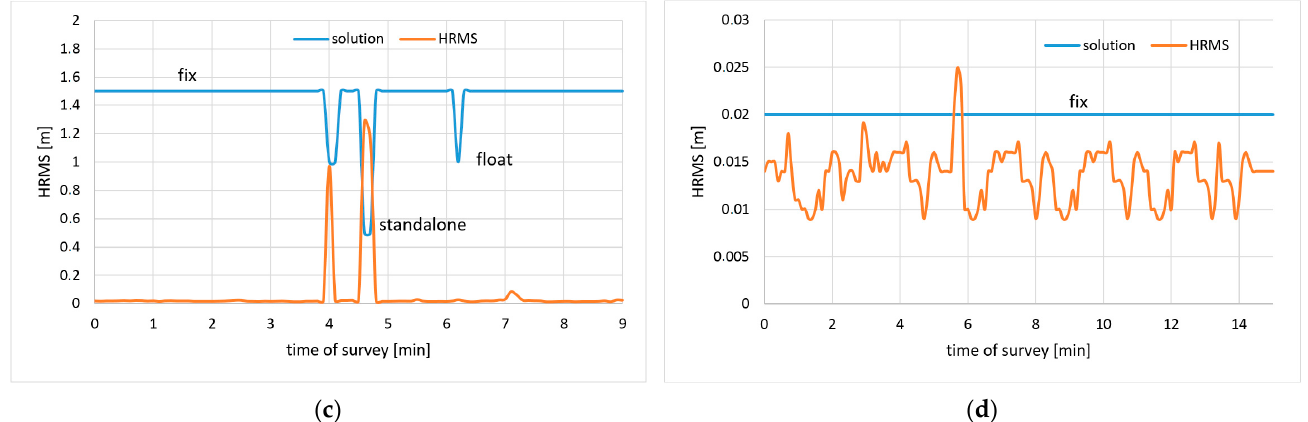
Figure 11. Positioning solution for 1—( a ), 2—( b ), 3—( c ) and 4—( d ) systems GNSS positioning.